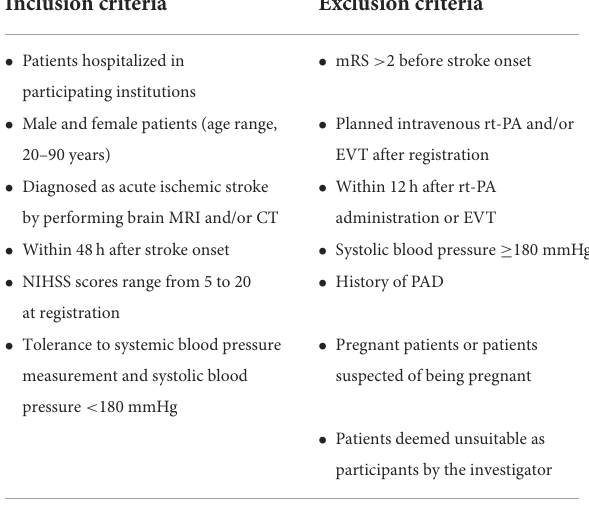
TABLE 1 Inclusion and exclusion